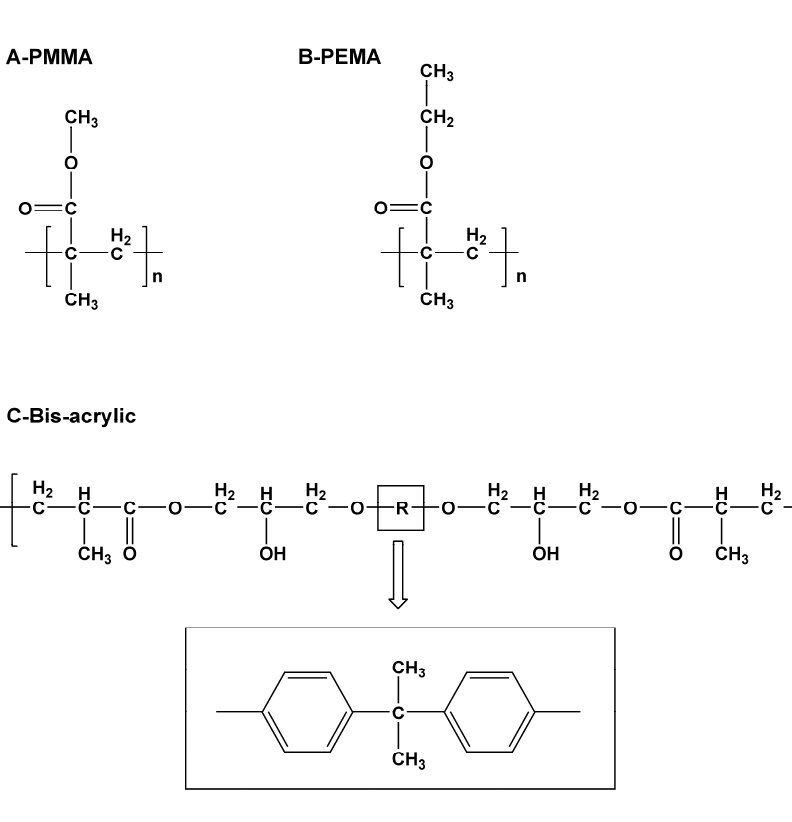
Figure 1. Repeating units of Polymethyl methacrylate (PMMA) ( A ); polyethyl methacrylate (PEMA) ( B ); and Bis-acrylic ( C ).